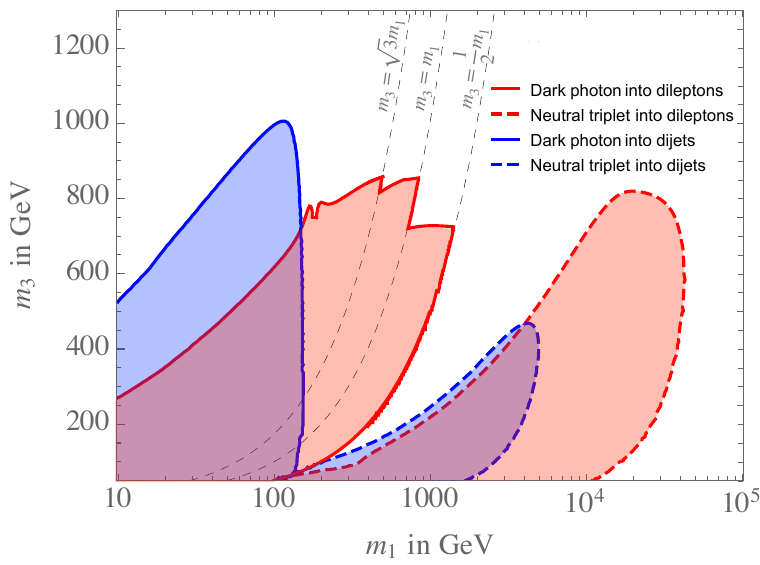
Figure 8 . Bounds in the triplet-singlet mass plane for ε = 10 − 8 and m 1 = 2 m γ performed by ATLAS that look for displaced dileptons in the inner tracker [92] and dijets in the muon spectrometer [94]. Regions with solid contours are excluded by the decay of the dark photons, while those with thick dashed contours are excluded by the decays of the 3 0 a smaller decay rate compared to the dark photon, its exclusion region extends to larger values of m 1 . The thin dashed lines identify the different kinematic regions of table 4, and can coincide with discontinuities in the value of the